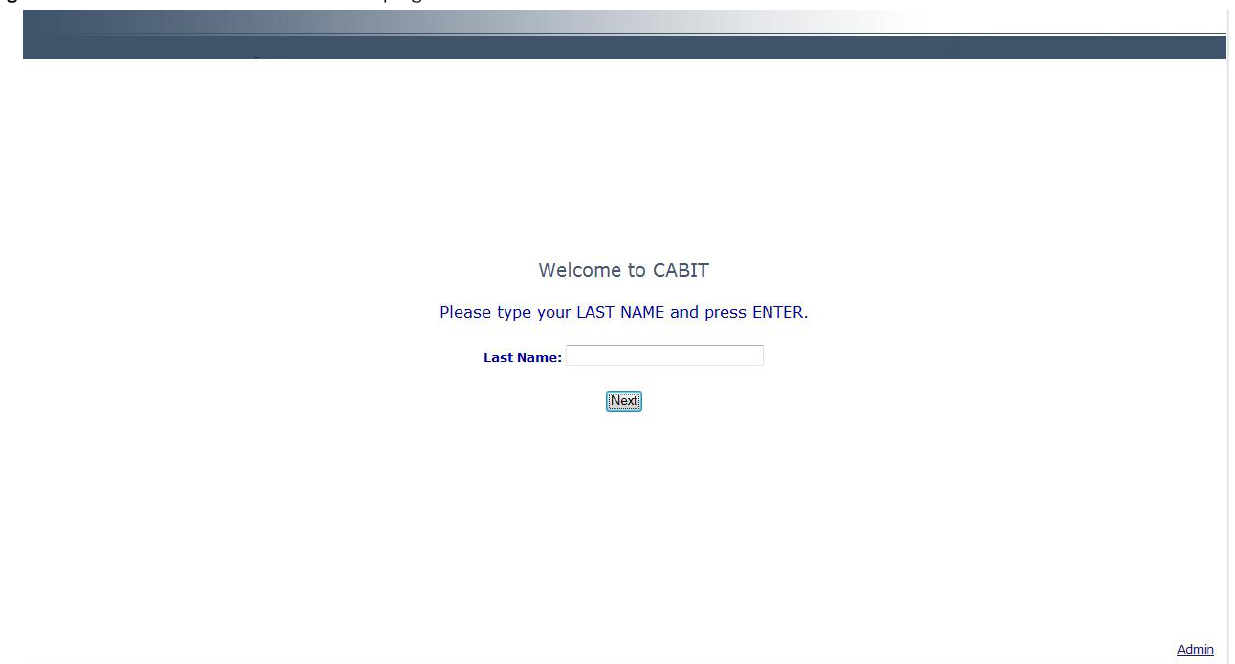
Figure 2. The welcome screen of the CABIT